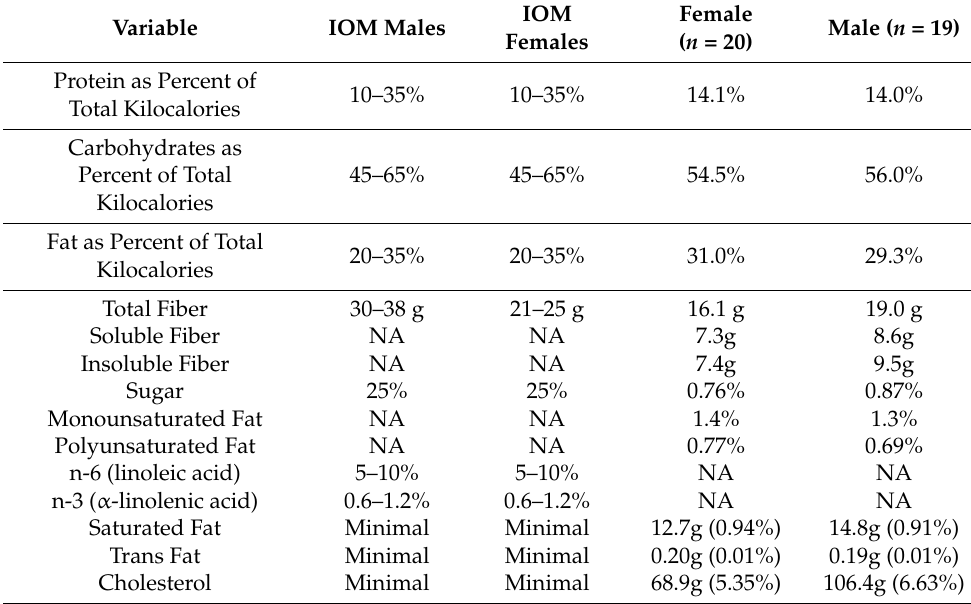
Table 1. Dietary Components as Compared to IOM’s Acceptable Macronutrient Distribution Ranges (AMDR).